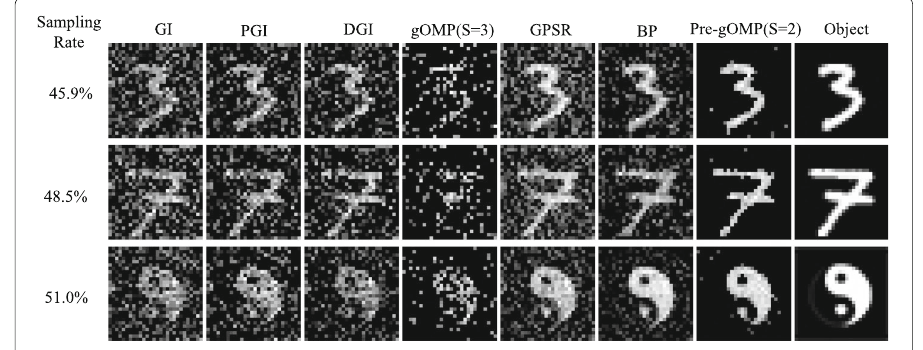
Fig. 4 Experimental results (the middle column) for GI, PGI, DGI, gOMP, GPSR, BP, and Pre-gOMP reconstruction algorithms. Objects are shown as the right one and the sampling rate selected to reconstruction are shown as the left one. Different objects are imaged and compared at different